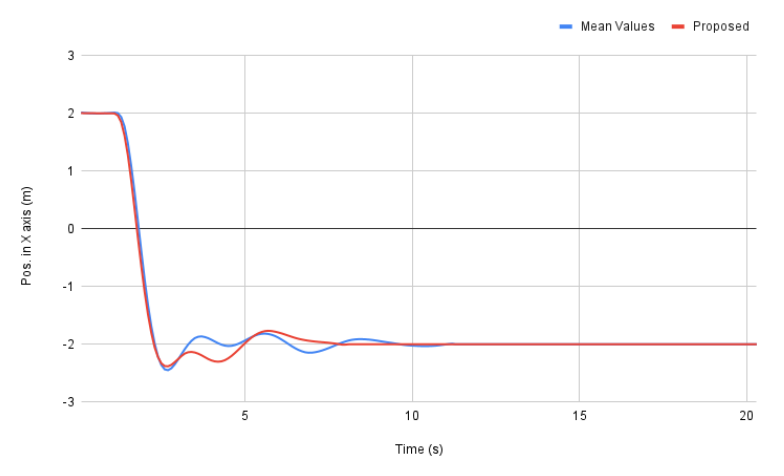
Figure 13. Comparison between the proposed method and using the mean values of the fuzzy logic